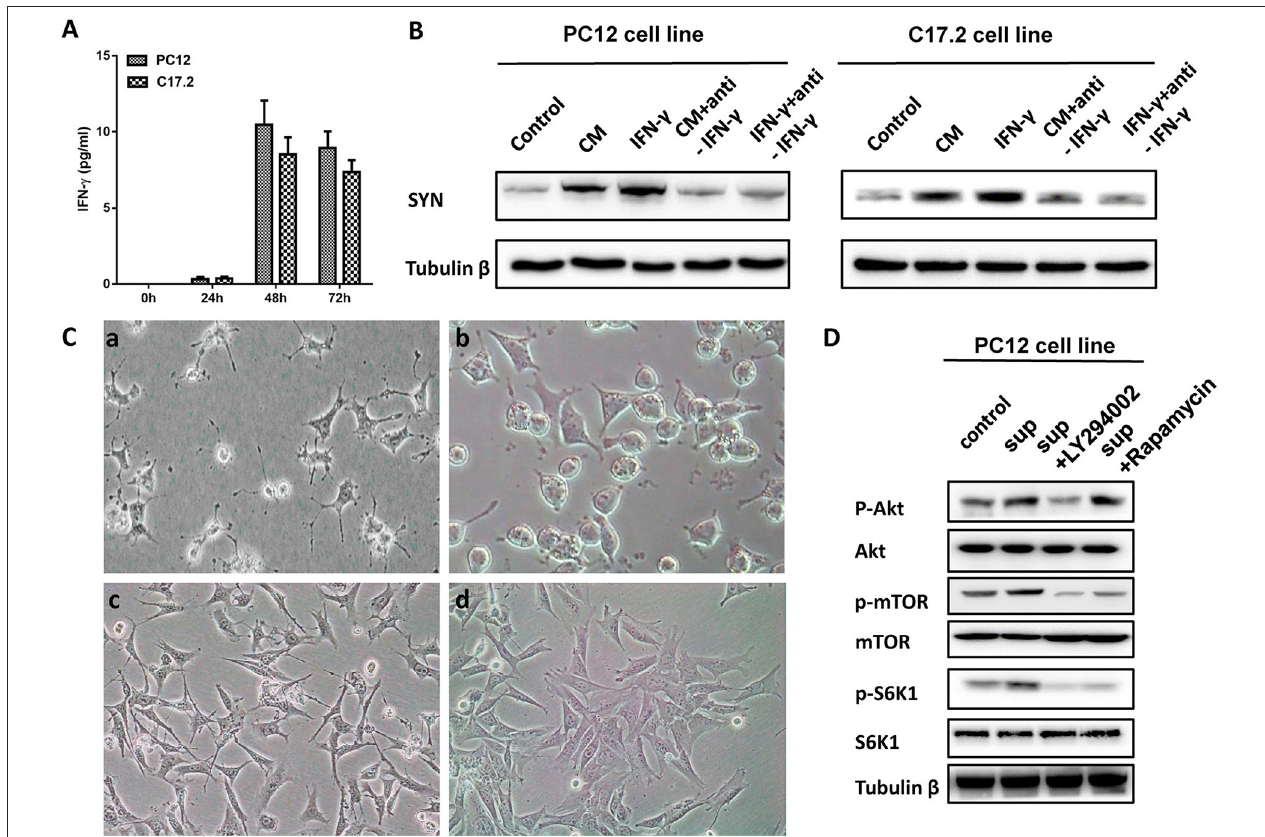
FIGURE 7 | IFN- γ involved in the role of M. smegmatis induced neuronal differentiation of PC12 cells and C17.2 cells. (A) IFN- γ in the supernatant of M. smegmatis was measured using a cytokine bead array by flow cytometry; (B) Western blotting analysis of exogenous IFN- γ treatment in PC12 and C17.2 cells; (C) PC12 cells were treated with culture supernatant of M. smegmatis (a) and supernatant plus LY294002 (b) for 48h; C17.2 cells were treated with culture supernatant of M. smegmatis (c) and supernatant plus LY294002 (d) for 48h (20 × ); (D) PC12 cells were exposed to RMPI 1640, supernatant of M. smegmatis , LY29402 for 24h respectively. Levels of p-AKT/AKT, p-mTOR/mTOR and p-S6K1/S6K1 were measured by western blot